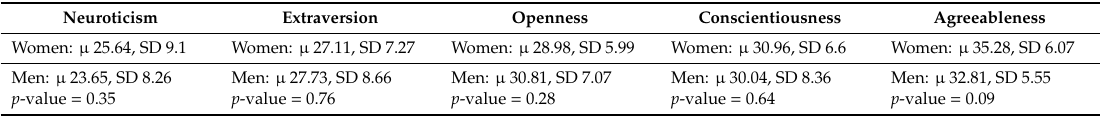
Table 10. Comparison of mean personality scores ( µ ) and stand deviation (SD) between men and women volunteers across five personality traits (Two sample t